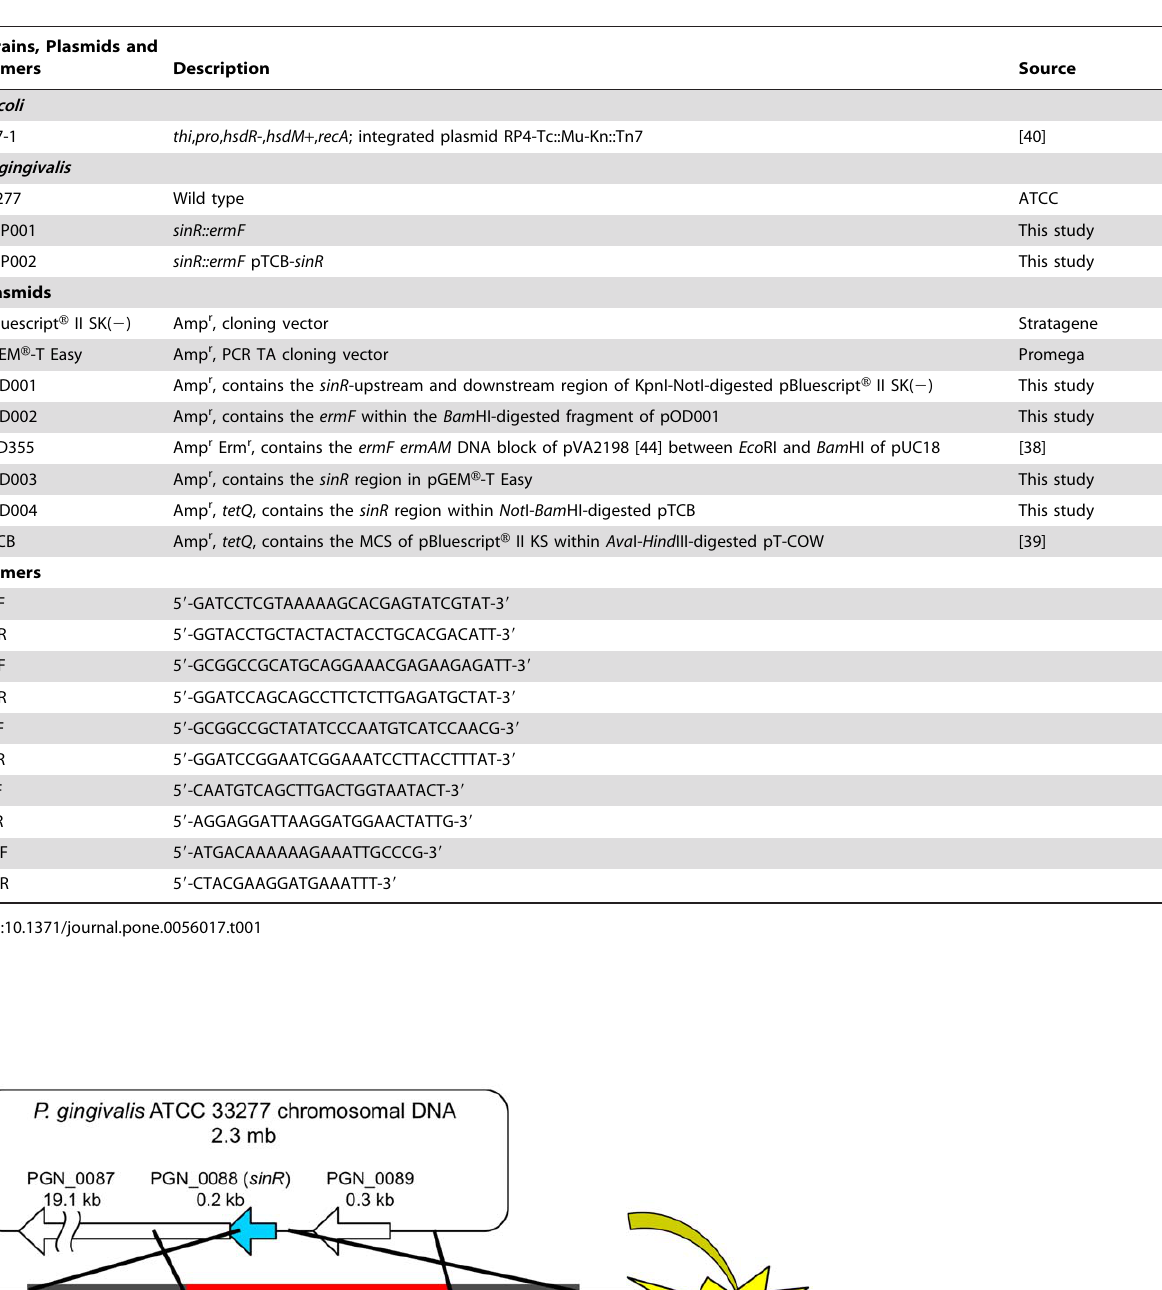
Table 1. Bacterial strains, plasmids, and primers used in this study.